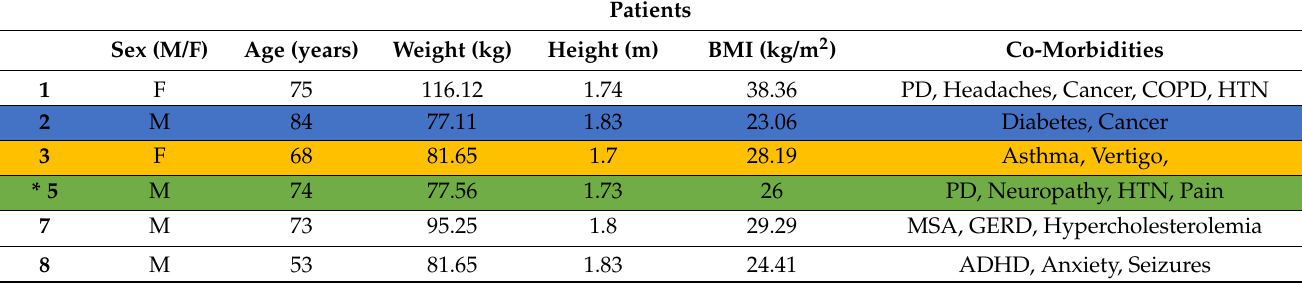
Table 1. Demographics and comorbidities of the entire patient population. The patients that were analyzed have been identified by colored boxes, and those of the analyzed patients taking angiotensin- converting enzyme (ACE) inhibitors are marked by asterisks. Blue box—Group A; Orange box— Group B; Green box—Group C. Six patients’ data could not be acquired and are, thus, not included in this table (patients 4, 6, 10, 14, 15, and 28). PD—Parkinson disease; HTN—hypertension; PS— parkinsonian syndrome; COPD—chronic obstructive pulmonary disease; MSA—multiple system atrophy; GERD—gastroesophageal reflux disease; ADHD—attention deficit/hyperactivity disorder; BPH—benign prostatic hyperplasia; CABG—coronary artery bypass graft; MI—myocardial infarction; CKD—chronic kidney